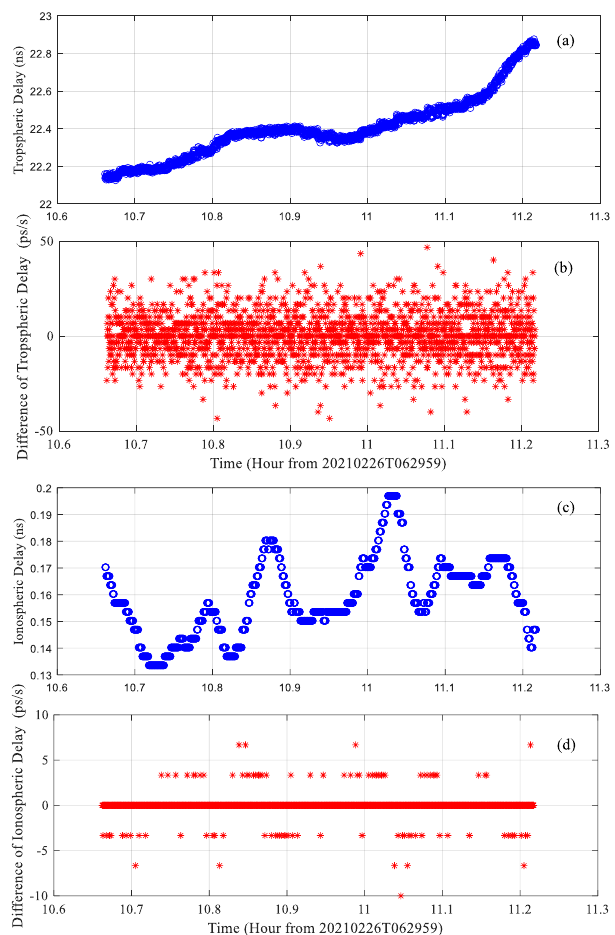
Figure 11. The tropospheric and ionospheric delay at JM station during the observation ( a ) tropo- spheric delay; ( b ) difference of tropospheric delay; ( c ) ionospheric delay; ( d ) difference of iono- spheric delay.